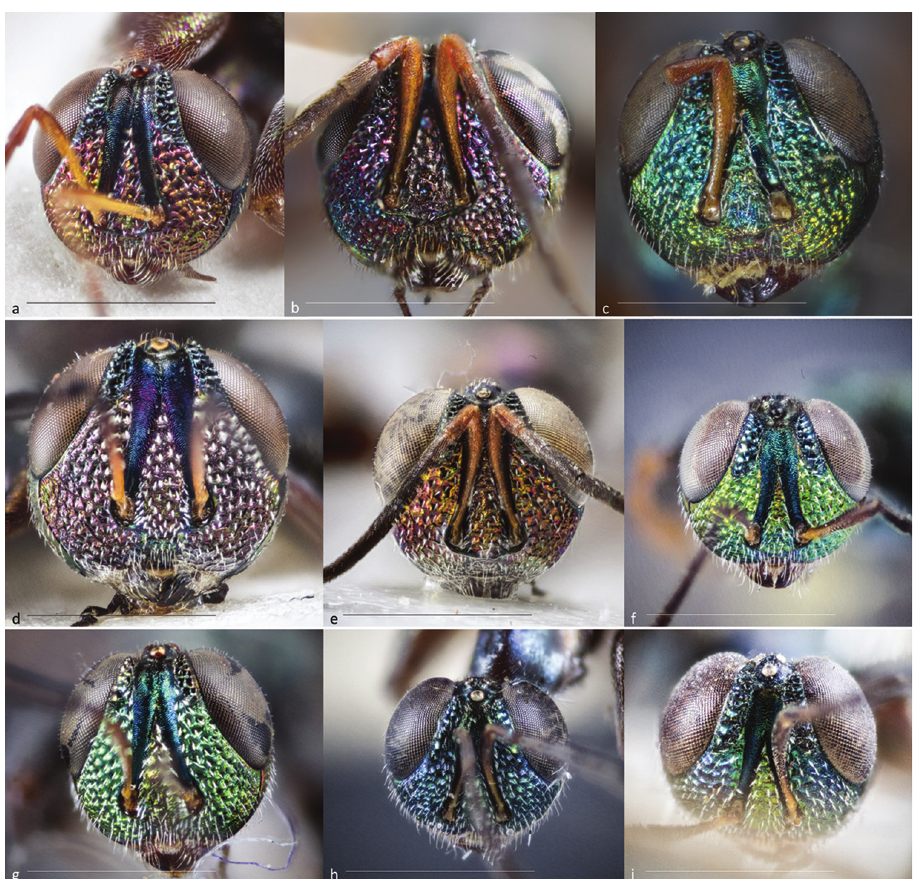
Figure 7. Head (frontal) III a O. magnifica (Risbec) (imaged specimen: OMag01, holotype) b O. mkom- aziensis sp. n. (OMk01, holotype) c O. monstrum syn. n. (OFo12, paratype) d O. namibiensis sp. n. (ONa01, holotype) e O. niehuisorum sp. n. (ONi01, holotype) f O. pumilae Yang (OPu01, paratype) g O. regiae Yang (ORe01, paratype) h O. srilankiensis sp. n. (OSr01, holotype) i O. tenuicollis (Walker) (OTe01, holotype). Scale bars: 1